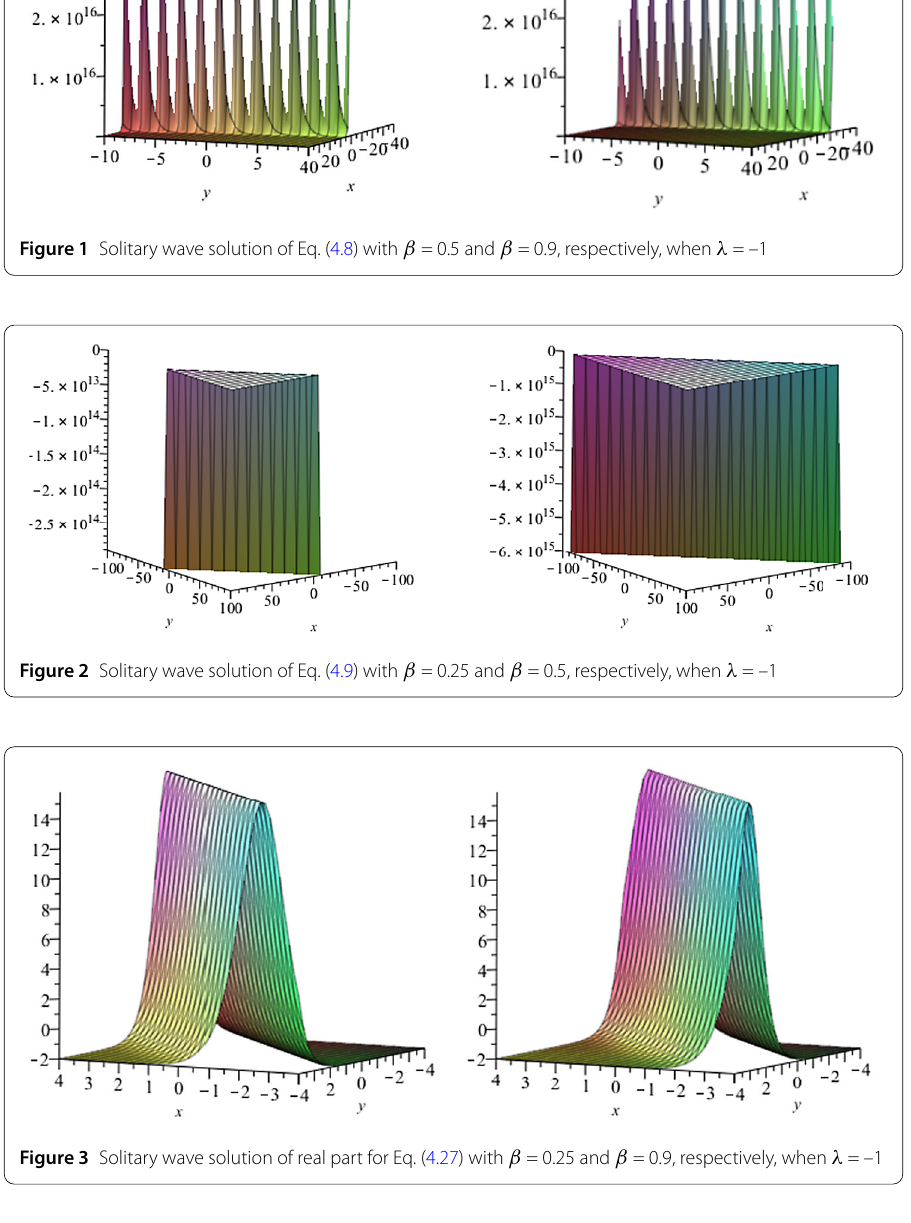
for (2 + 1)-dimensional BP model and (3 + 1)-dimensional KdV–ZK equation with time- fractional derivative are obtained. When the parameters μ , A 1 , and A 2 are given special values, the solitary wave solutions (4.8), (4.9), (4.12), (4.13), (4.27) and (4.28) and the peri- odic solutions (4.16), (4.17), (4.20), (4.21), (4.31) and (4.32) are obtained. When μ = 0 and β i = 0 in Eq. (3.1) and Eq. (3.13), respectively, the (